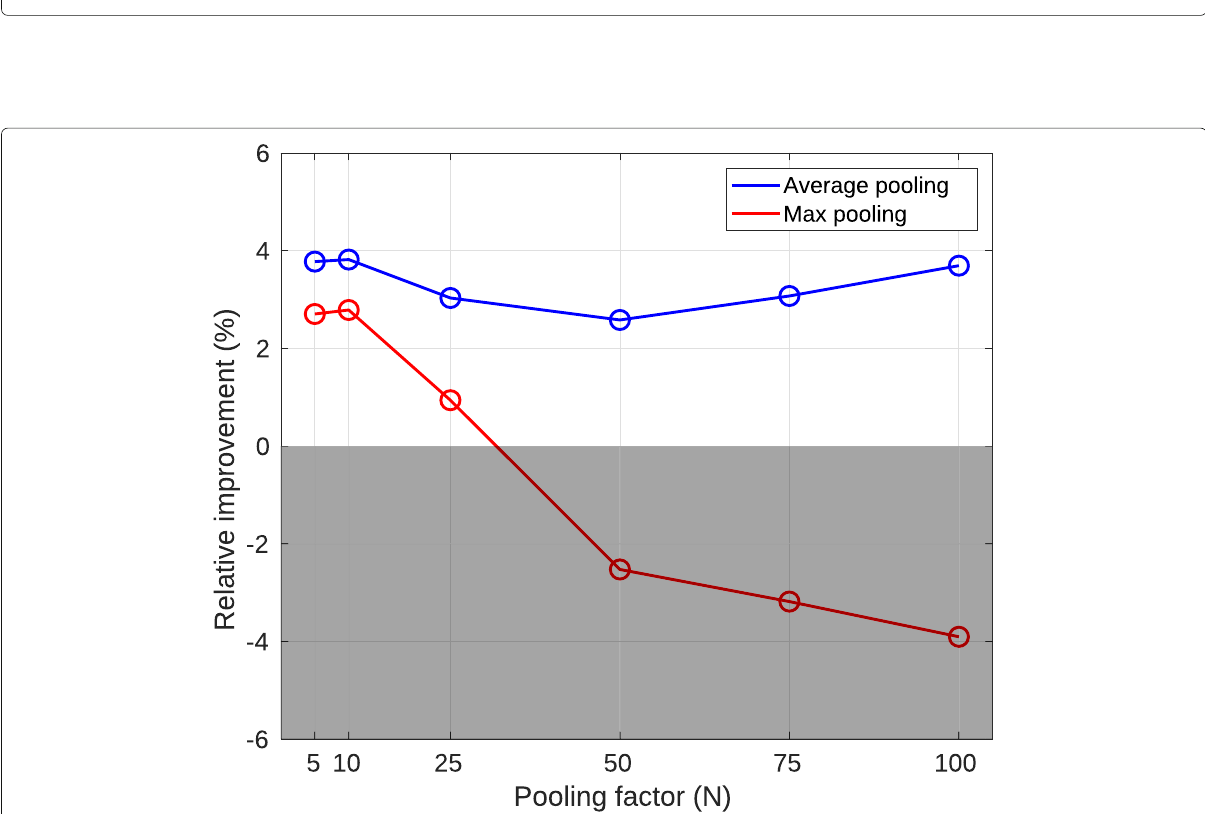
Fig. 6 Relative improvement over the baseline RNN classifier for different pooling factors and pooling techniques using the BLSTM 1 Pool BLSTM 2